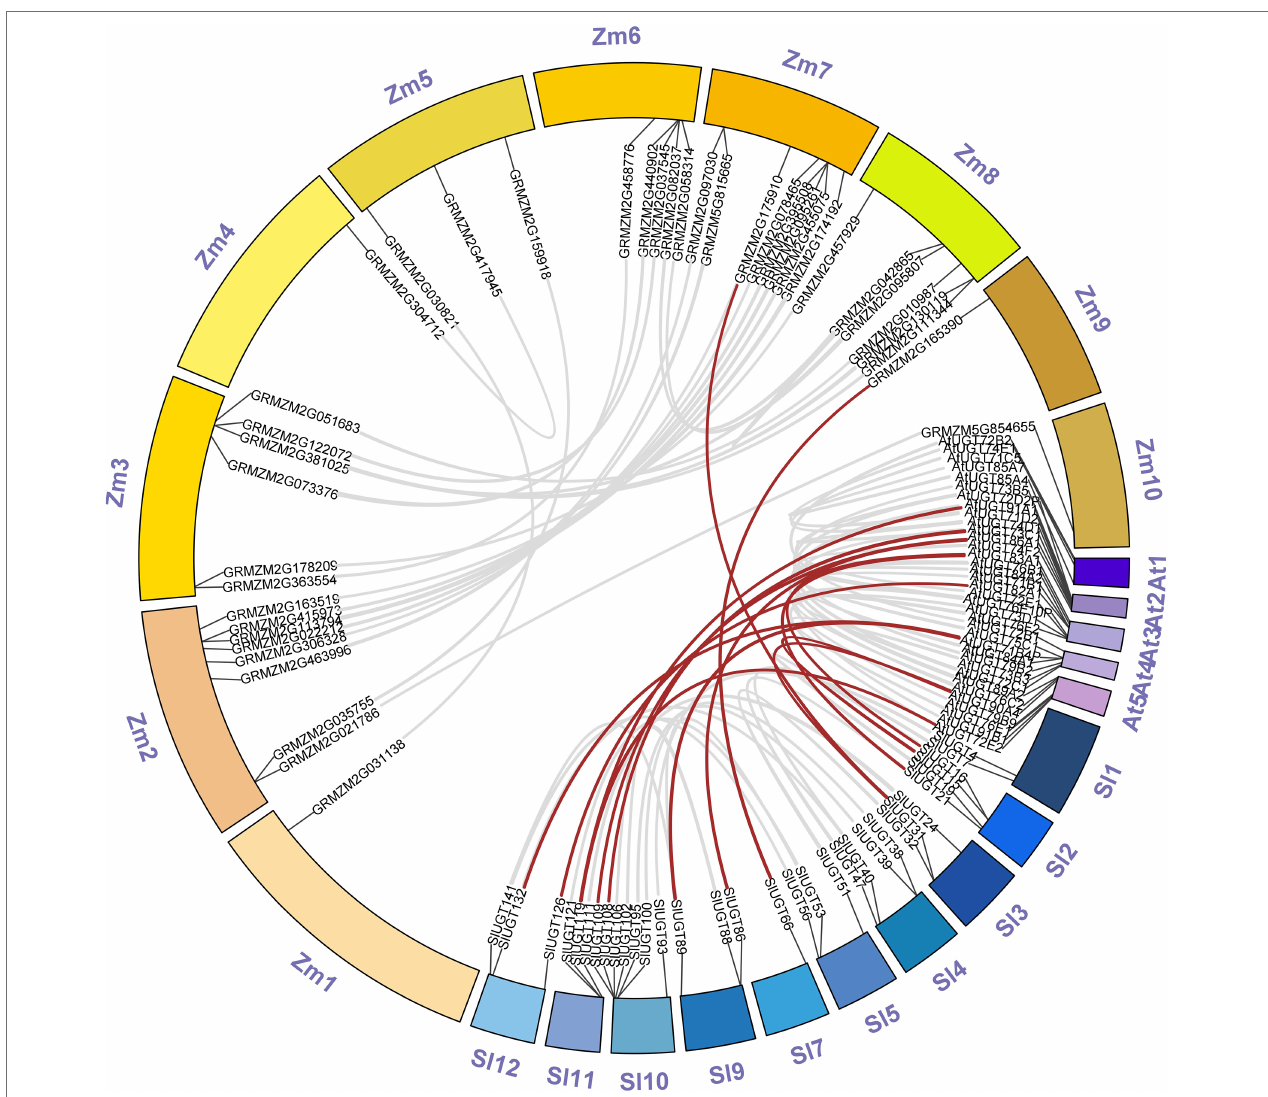
FIGURE 6 | Synteny analysis of UGT genes between tomato and two representative plant species ( Arabidopsis thaliana and Z. mays ). “Sl” was on behalf of chromosomes of Solanum lycopersicum , “At” was on behalf of chromosomes of A. thaliana and “Zm” was on behalf of chromosomes of Z. mays